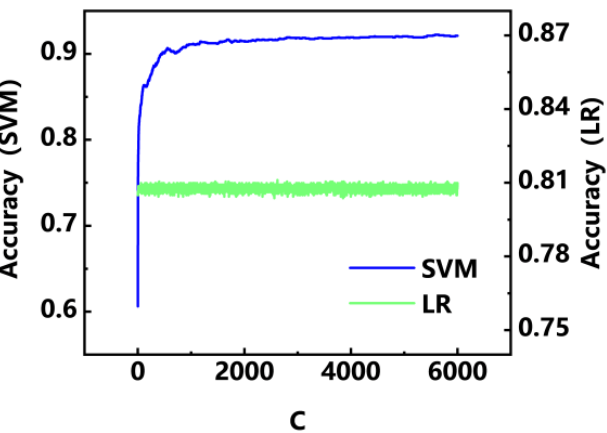
Figure 5. The hyperparameter C value and accuracy curve of SVM and LR, respectively.